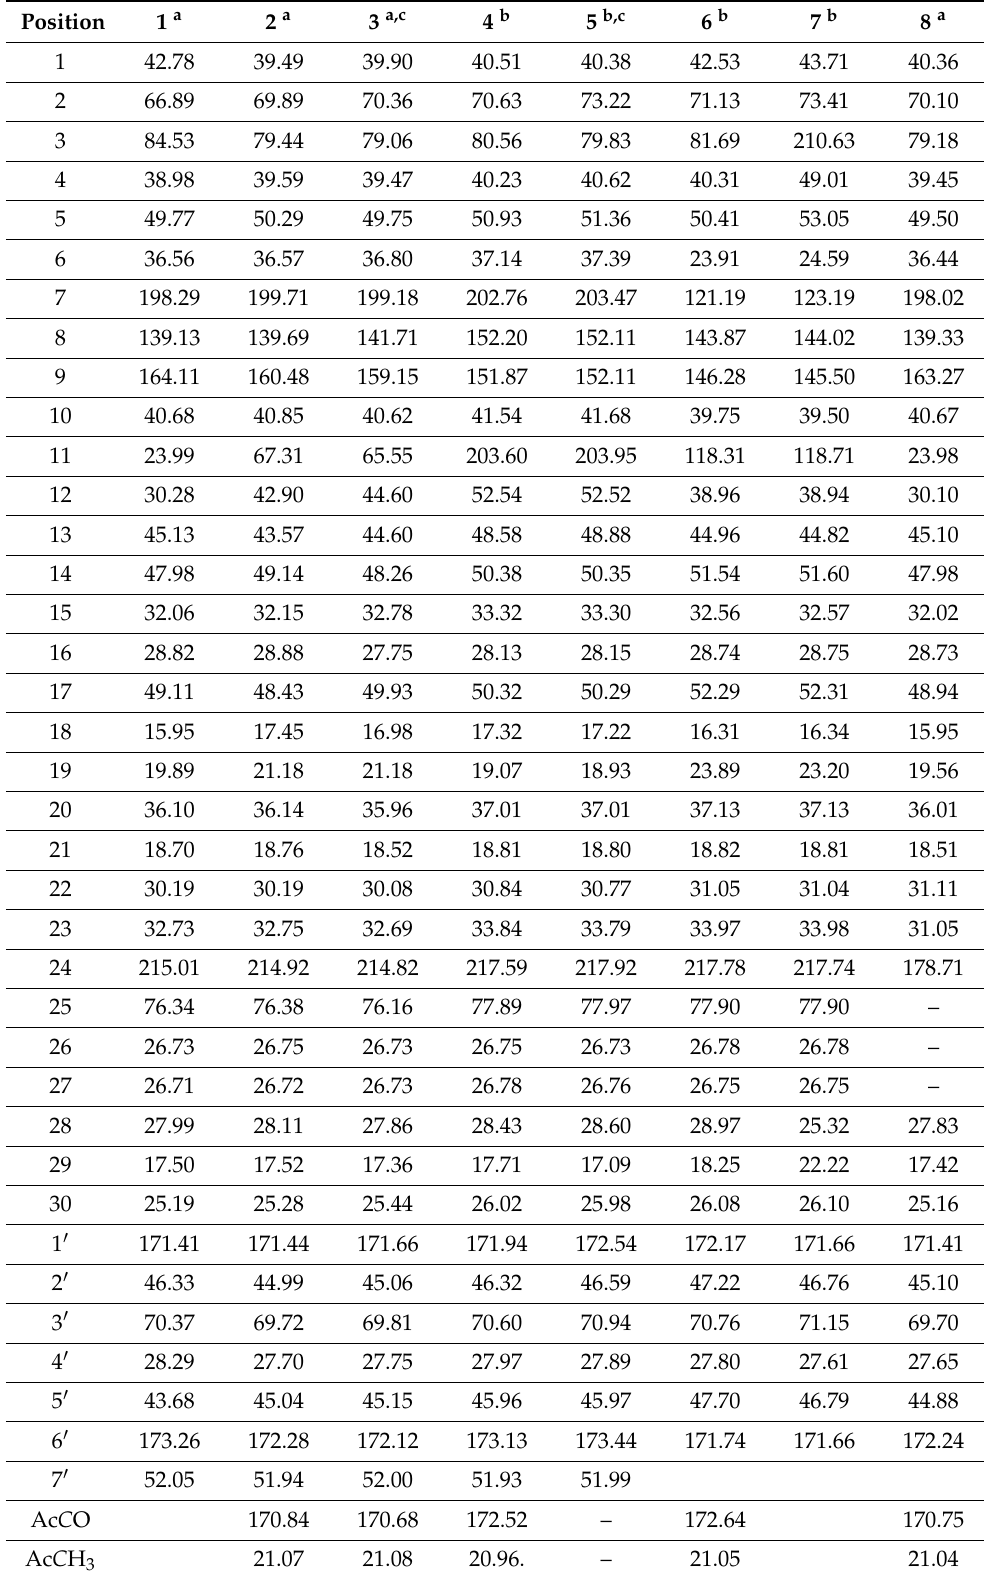
Table 2. 13 C NMR data of pholiols L–Q ( 1 – 8 ) (125 MHz, δ